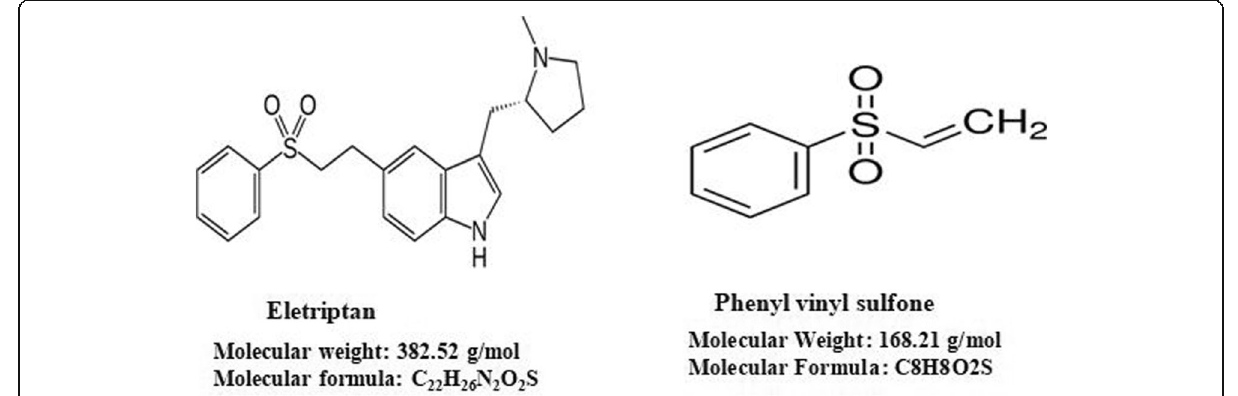
Fig. 1 Chemical structures of eletriptan and phenyl vinyl